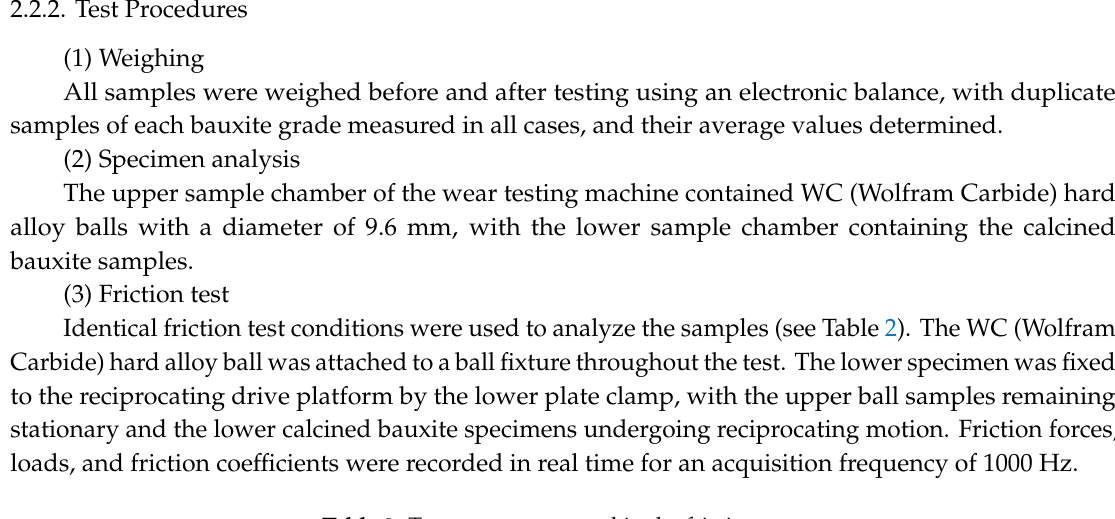
Table 2. Test parameters used in the friction test.